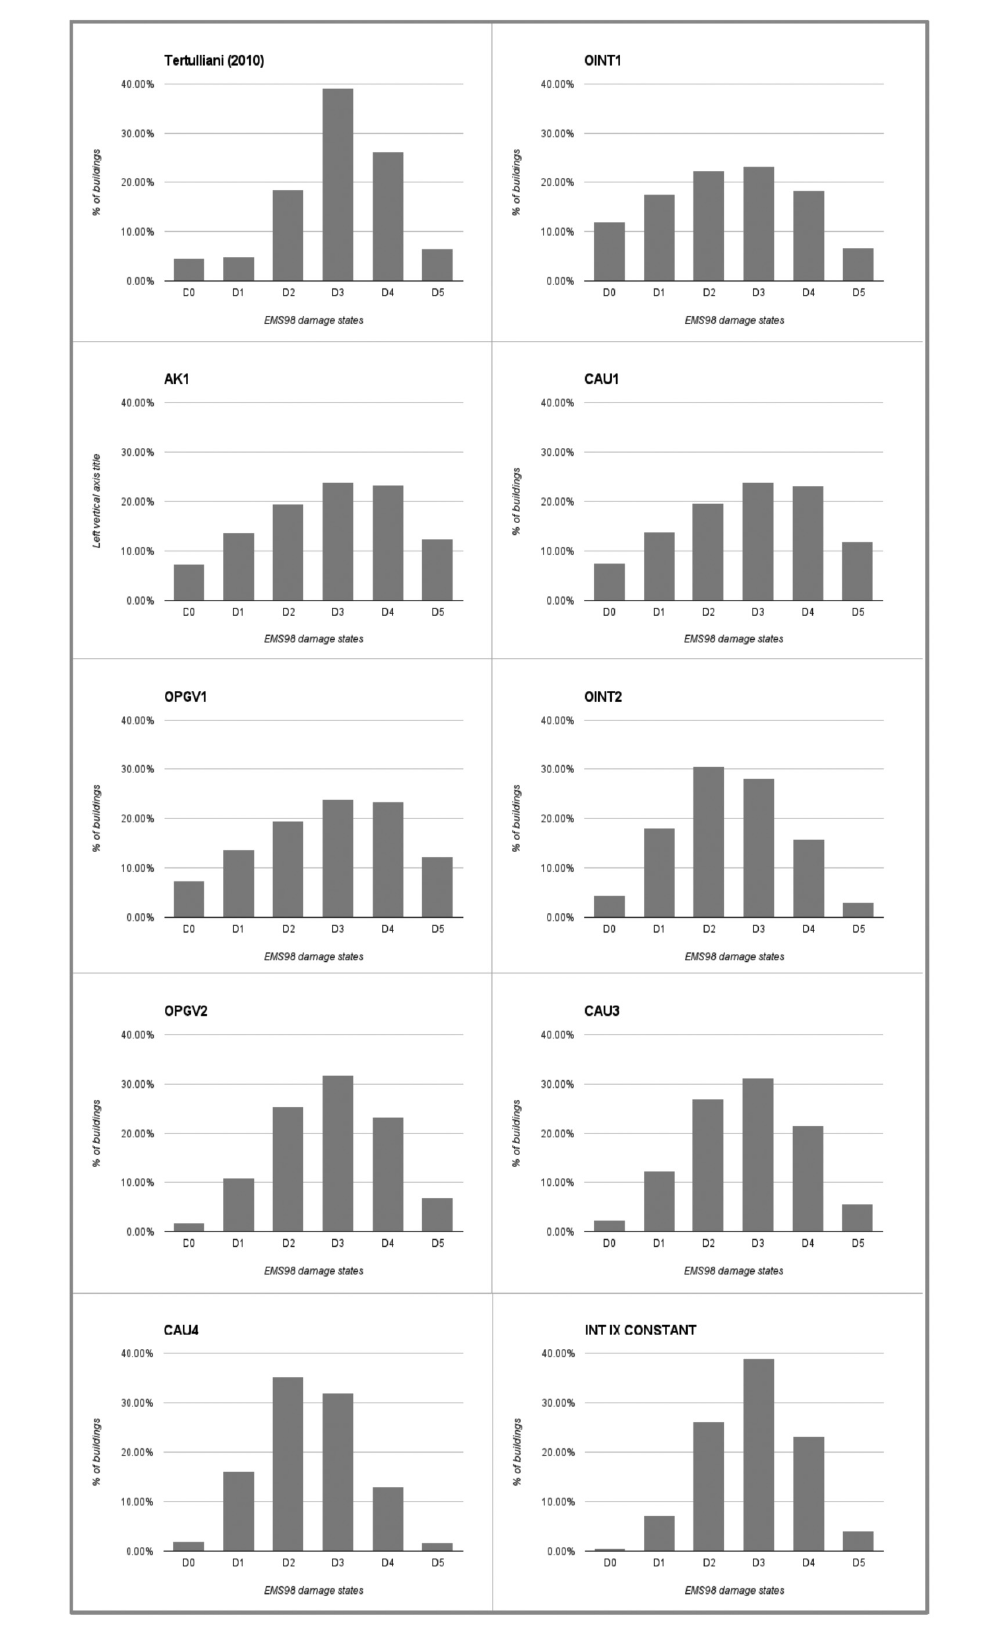
Figure 8. Distribution of damage states in L’Aquila observed by Tertulliani et al. [2010] and